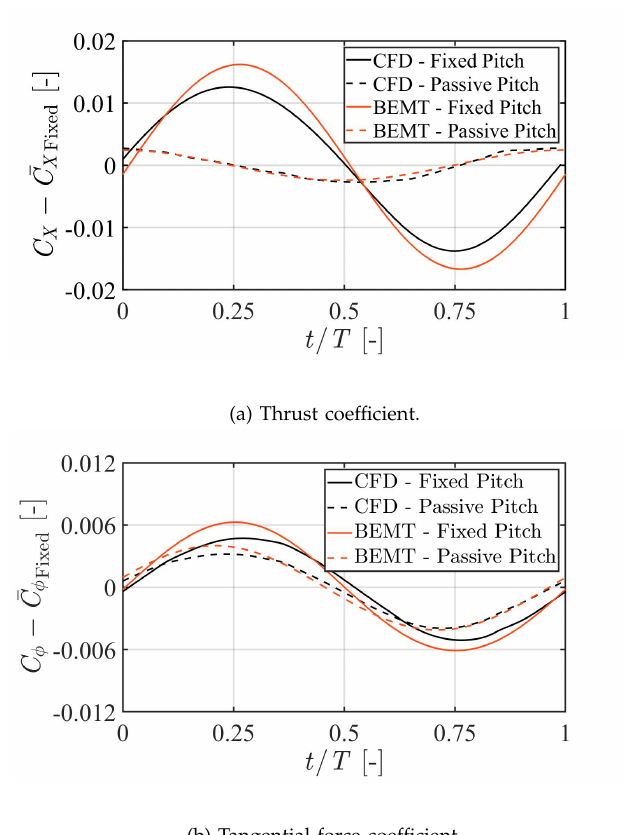
Fig. 13: Phased-averaged thrust coefficient C X (a) and tangential coefficient C ϕ (b) versus the nondimensional time t/T predicted with CFD and BEMT. The mean of the thrust ( ¯ C X Fixed ) and tangential ( ¯ C ϕ Fixed ) force coefficients are subtracted to highlight the differences in the amplitude of the oscillations.